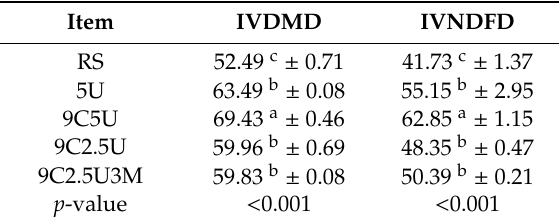
Table 4. E ff ect of ammoniation treatment on the digestibility of DM and NDF of rice straw in vitro after 60 days of storage.